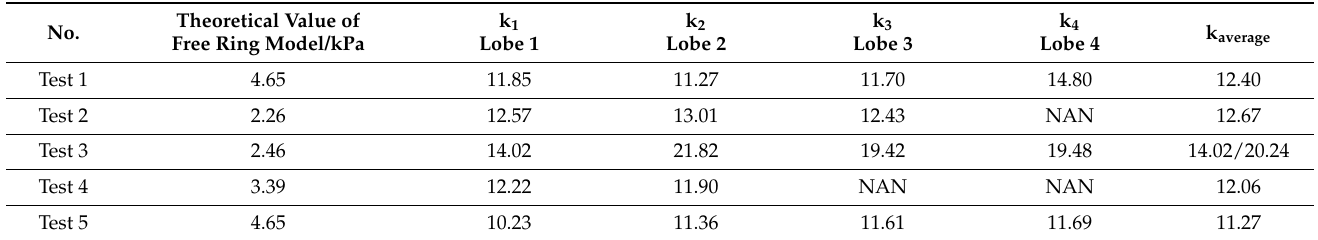
Table 3. Enhancement coefficient k under different buckling